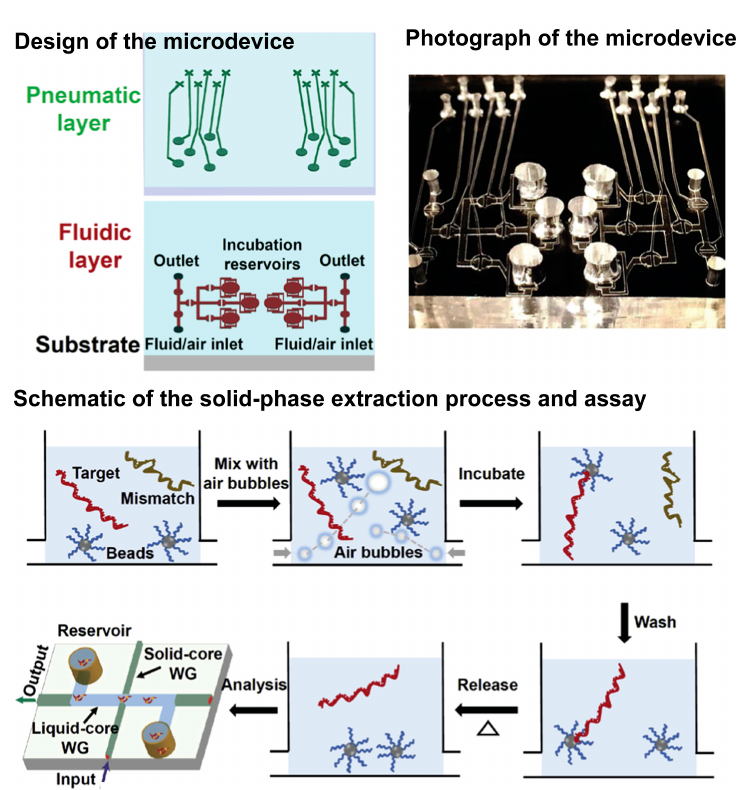
Figure 9. Schematic representation of the fabrication method for the automated microfluidic sample preparation multiplexer with lifting-gate microvalves for Ebola virus detection. Reprinted with permission from [129]. Copyright (2017) Elsevier.